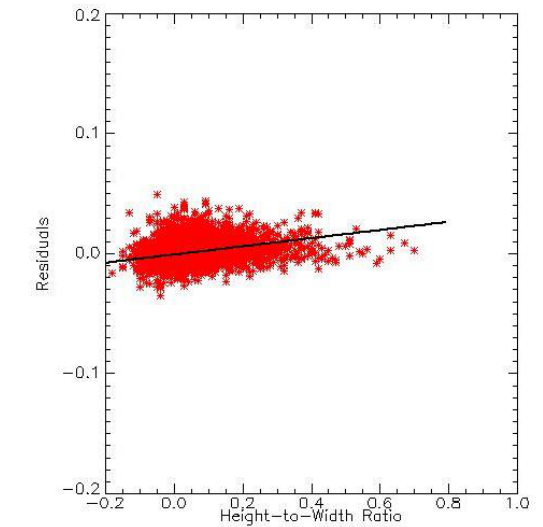
Figure 10. The residuals from the line of best fit in Figure 7 (y- axis) plotted against height-to-width ratio (x-axis) for pixels within the study area. A line of best fit between the residuals and the derived height-to-width ratio is also included in the plot.